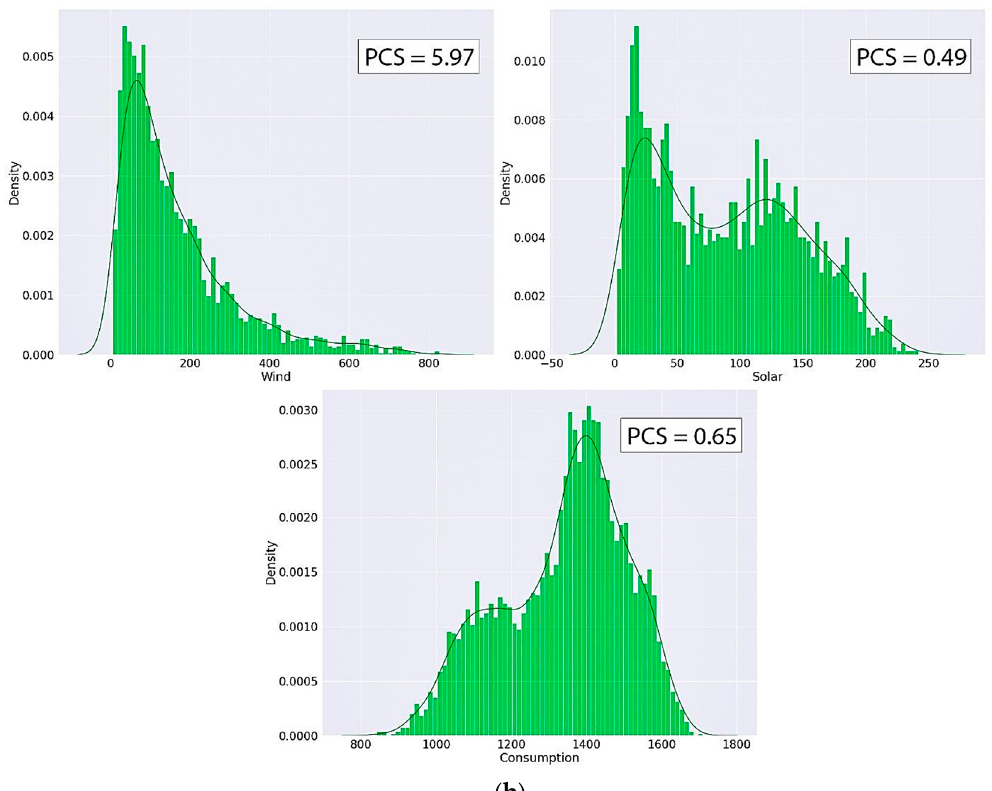
Figure 3. Distribution of the variables using ( a ) box plot and ( b ) histogram and density plot. The Pearson correlation coefficient (PCS) values show the measure of skewness.